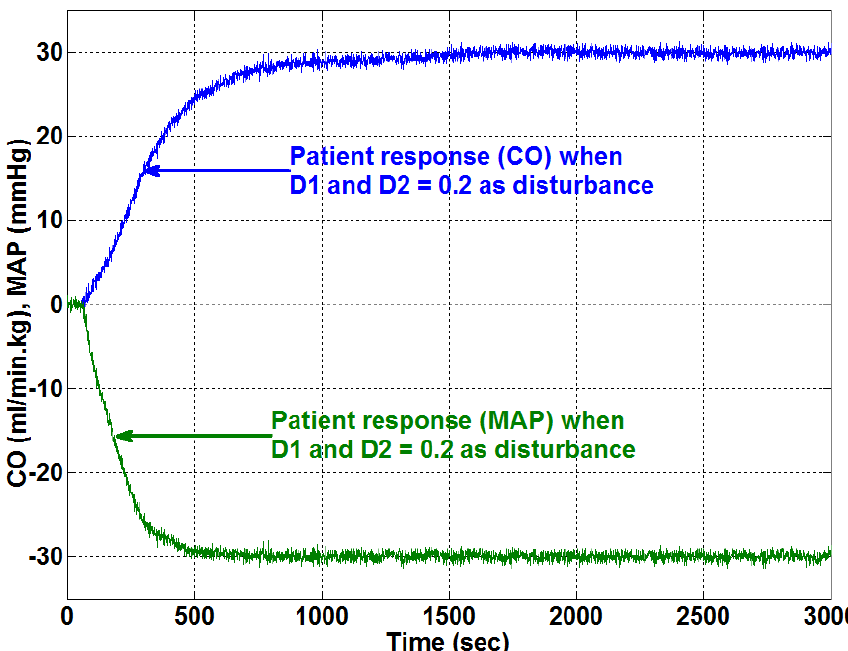
Figure 13: Nominal response with disturbance variance D1=D2=0.2 and set points +30 for CO and -30 for MAP